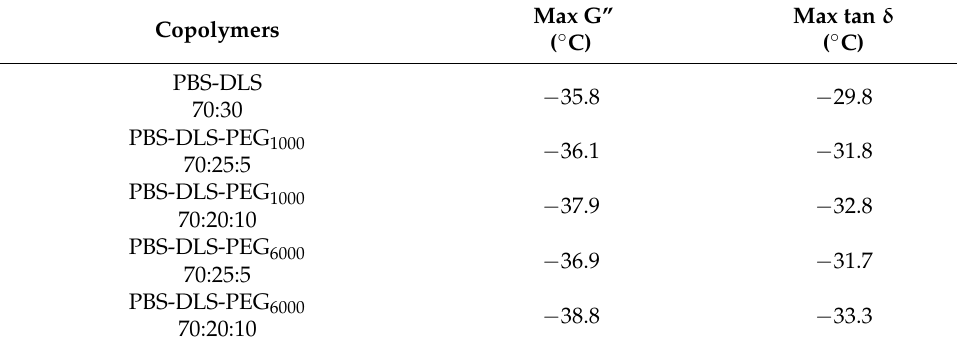
Table 6. The comparison of T g values taken at max G” and max tan δ